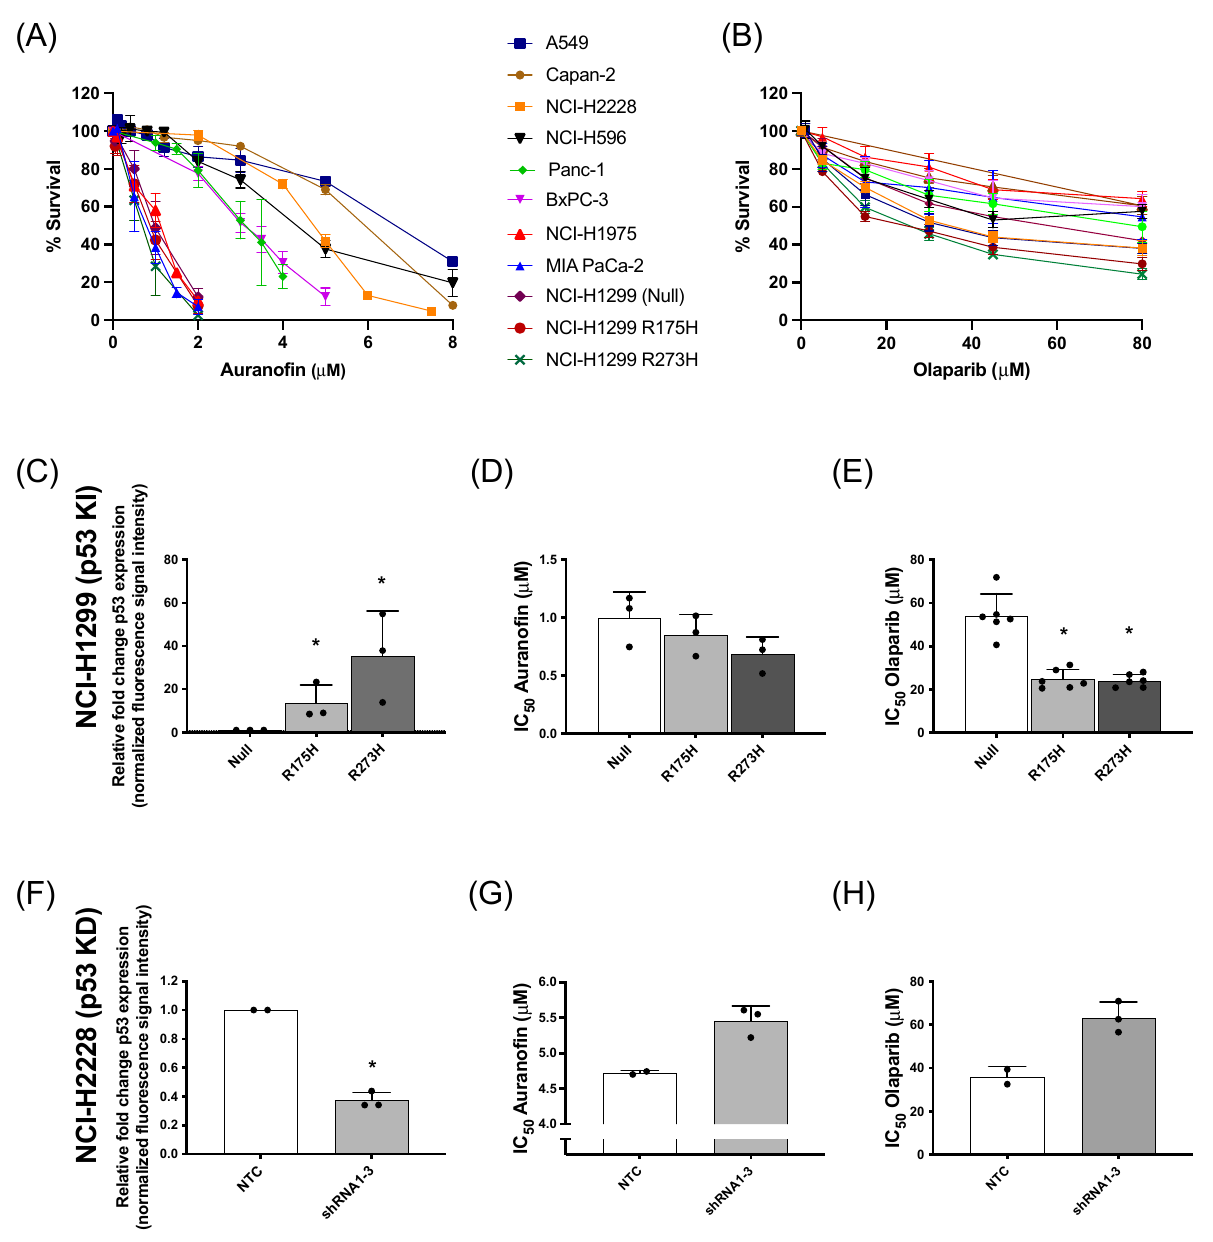
Figure 1. Cytotoxic response to AF and olaparib monotherapy in (isogenic) NSCLC and PDAC cell lines with distinct p53 backgrounds. ( A , B ) Dose-response survival curves after 72 h of AF (0–8 µM) ( A ) and olaparib treatment (0–80 µM) ( B ) in a panel of NSCLC and PDAC cell lines. ( C ) Fold change of p53 protein expression, relative to NCI-H1299 null control cells (determined by Western blotting), in the isogenic NCI-H1299 cell line panel. Representative Western blots are shown in Figure S2A. ( D , E ) IC 50 values (µM) after 72 h of AF ( D ) or olaparib ( E ) treatment in the isogenic NCI–H1299 cell panel (determined by SRB assay). ( F ) Fold change of p53 protein expression, relative to NCI-H2228 NTC cells (determined by Western blotting), in the isogenic NCI-H2228 cells transfected with TP53 shRNA viral vector 1 to 3. Representative Western blots are shown in Figure S2B. ( G , H ) IC 50 values (µM) after 72 h of AF ( G ) or olaparib ( H ) treatment in the isogenic NCI-H2228 cells transfected with either NTC or TP53 shRNA 1 to 3 (determined by SRB assay). Experiments were performed at least in duplicate with every dot representing a different repeat. Error bars represent the standard deviation. * p ≤ 0.05 significant differences. KI: knock-in p53; KD: knock-down p53; NTC: non-template control, parental cell line.